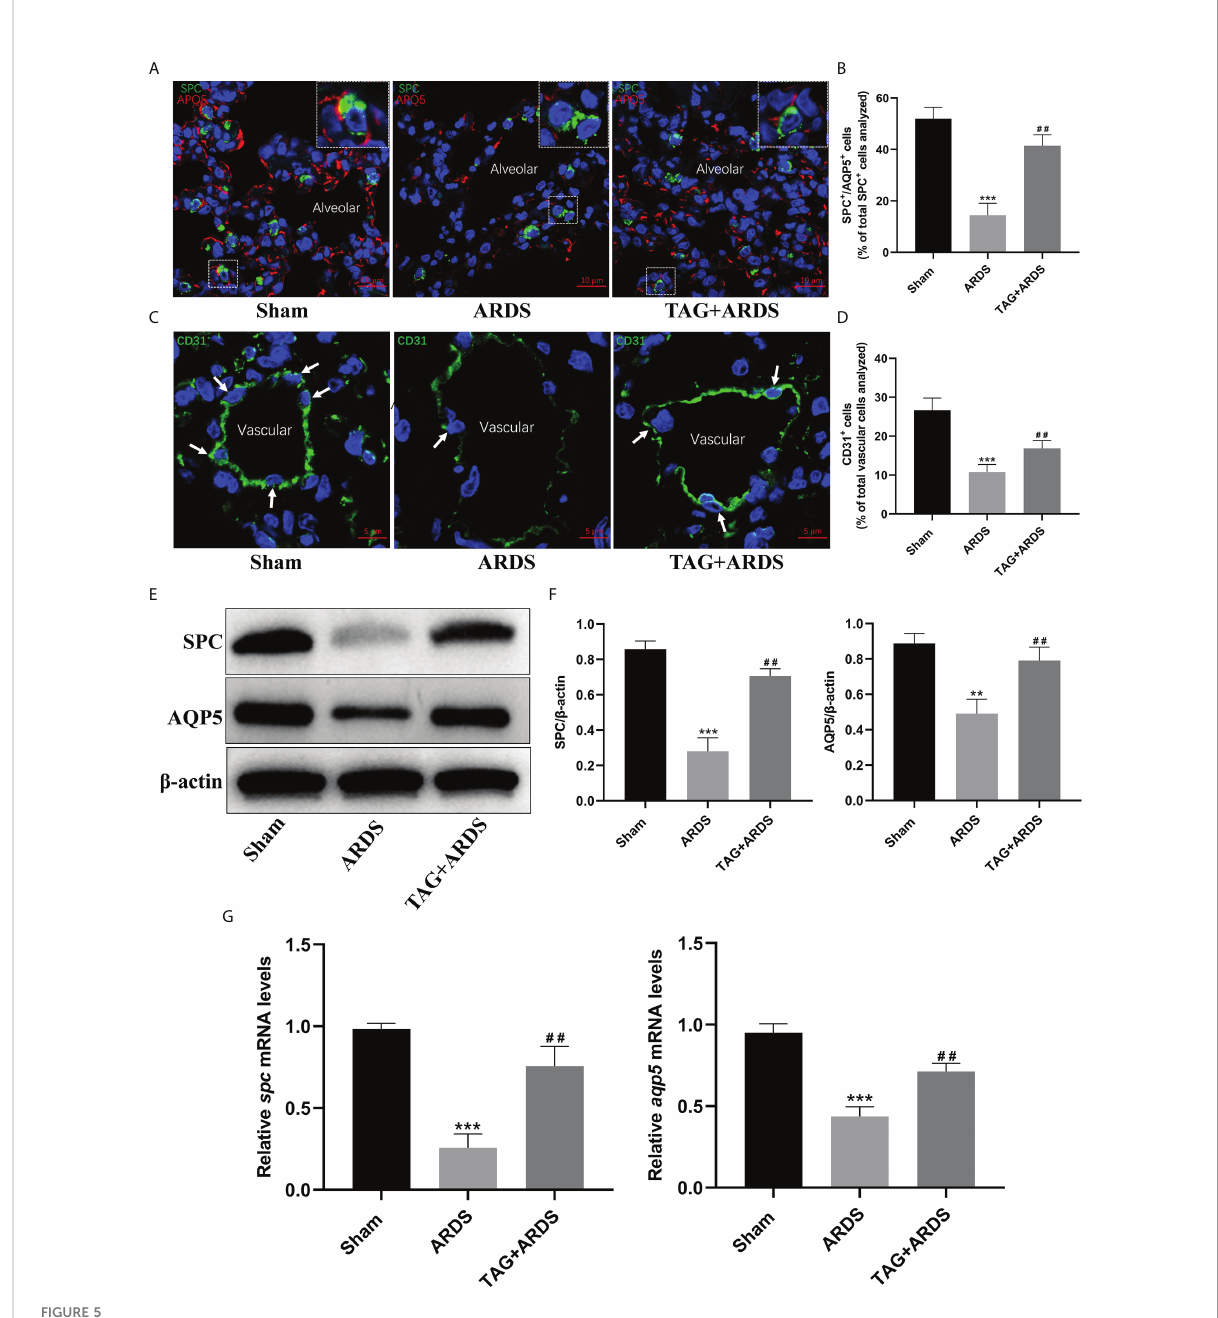
FIGURE 5 Effects of TAG on ARDS-induced alveolar and endothelial damage. (A, B) Representative immuno fl uorescence images and quanti fi cation of alveolar type I and II epithelial cells in Sham, ARDS, and TAG + ARDS groups. The lungs were co-immunostained for SPC and AQP5 alveolar epithelial-speci fi c markers (scale bar = 10 m m). The marker-positive cells were quanti fi ed with a confocal microscope. (C, D) Representative immuno fl uorescence images and quanti fi cation of CD31-positive vascular endothelial cells in each group. Arrows represent vascular endothelial cells (scale bar = 5 m m). (E, F) Representative WB images and assessment of SPC and AQP5 protein expression levels in each group. (G) RT- qPCR results show that the transcripts levels for spc and aqp5 mRNA. Data are presented as mean ± SD. ** p < 0.01, *** p < 0.001, compared with the Sham group; ## p < 0.01, compared with the ARDS group. TAG, D-tagatose; ARDS, acute respiratory distress syndrome; SPC, surfactant protein C; AQP5, aquaporin